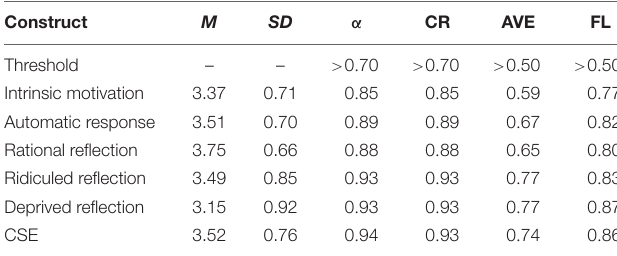
TABLE 2 | Analysis of validity and reliability.